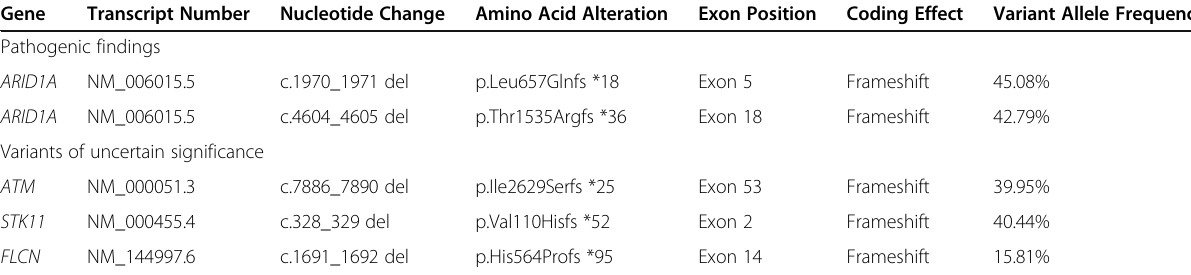
Table 1 Genetic alterations identified by next-generation